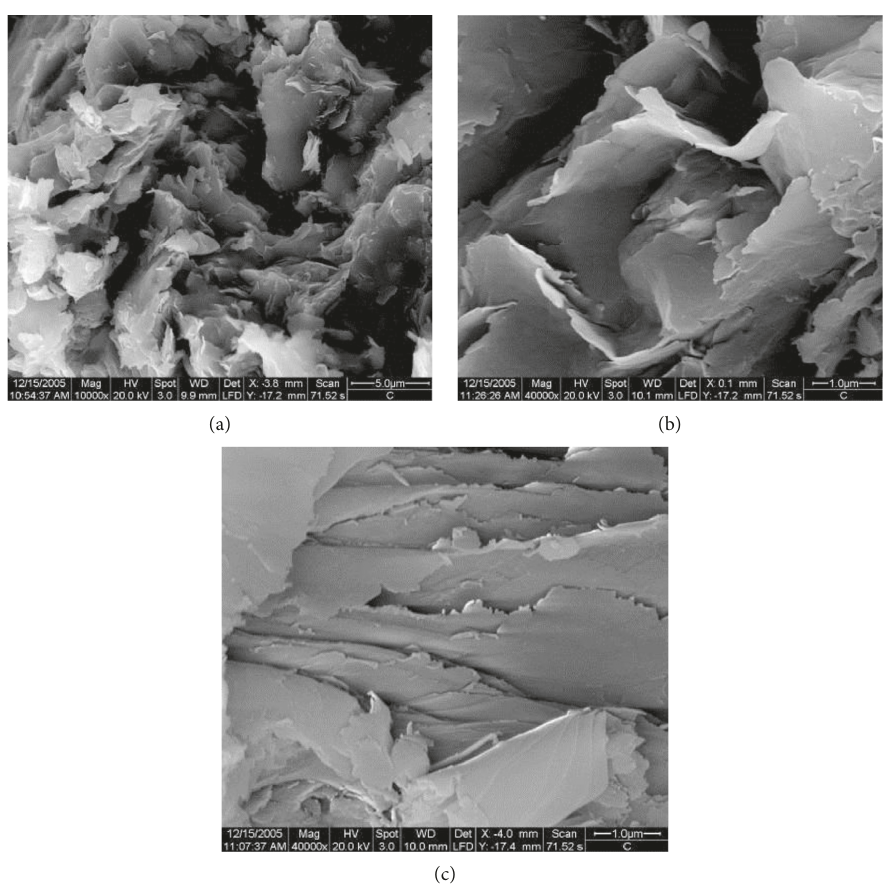
Figure 5: SEM images of red clay samples in Wushan road station. (a) × 10000 filament I/S. (b) × 40,000 the typically flake I/S. (c) × 40,000 flake I/S, curled lamellar S.